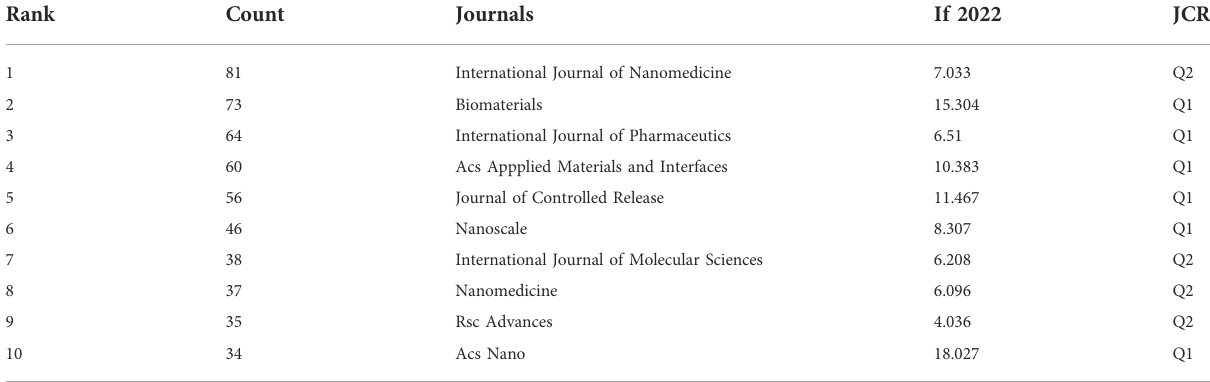
TABLE 2 Top ten journals publishing related publications.